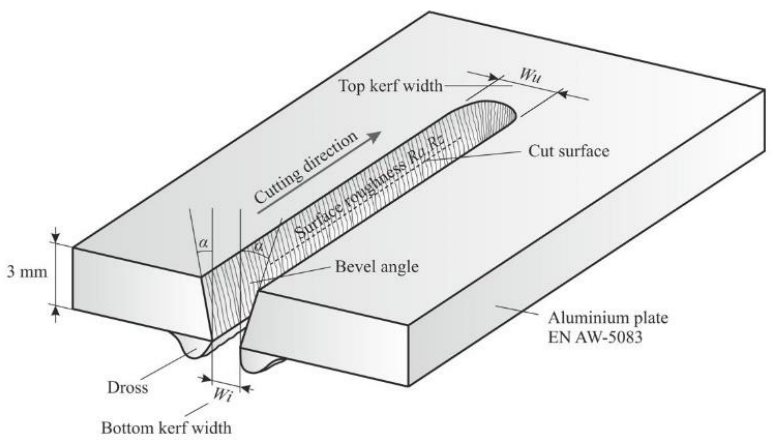
Figure 2. Cut quality responses.